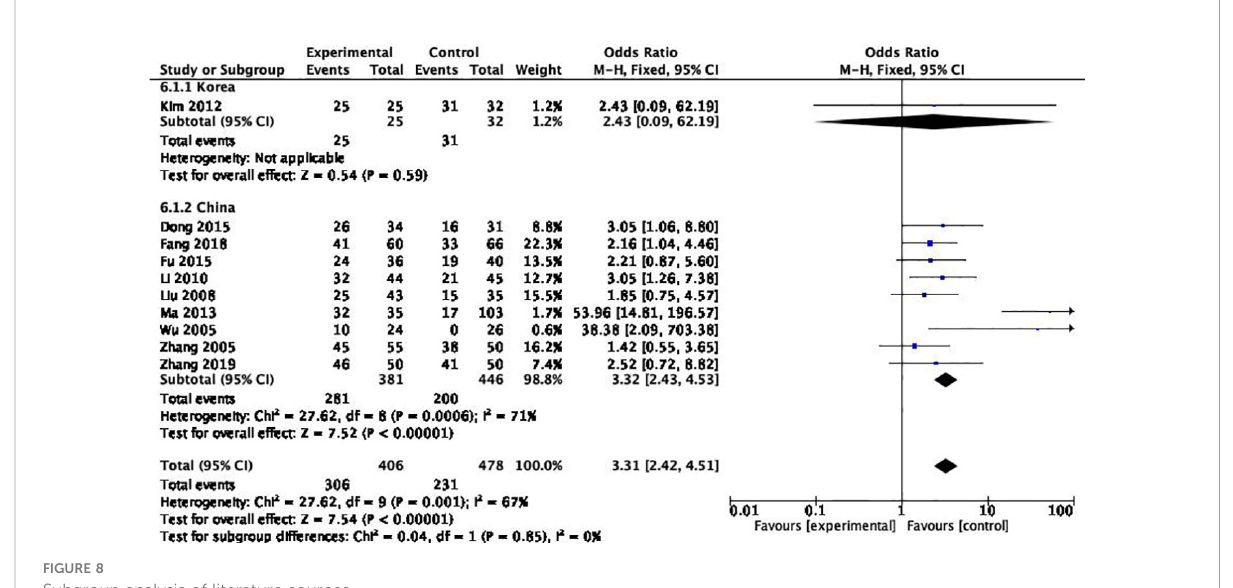
FIGURE 8 Subgroup analysis of literature